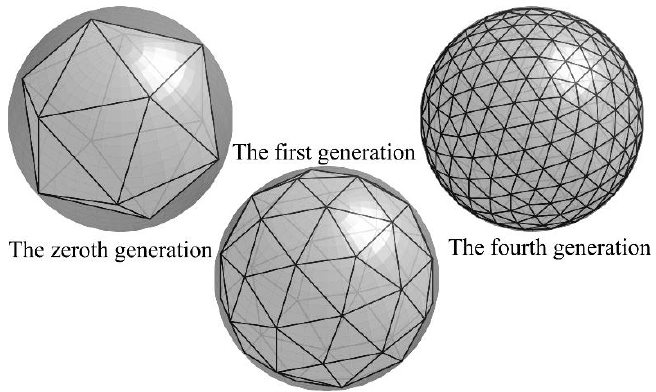
Figure 4. Icosahedron-based vertices on a sphere. The zeroth, first, and fourth-generation vertices are shown with triangulation.